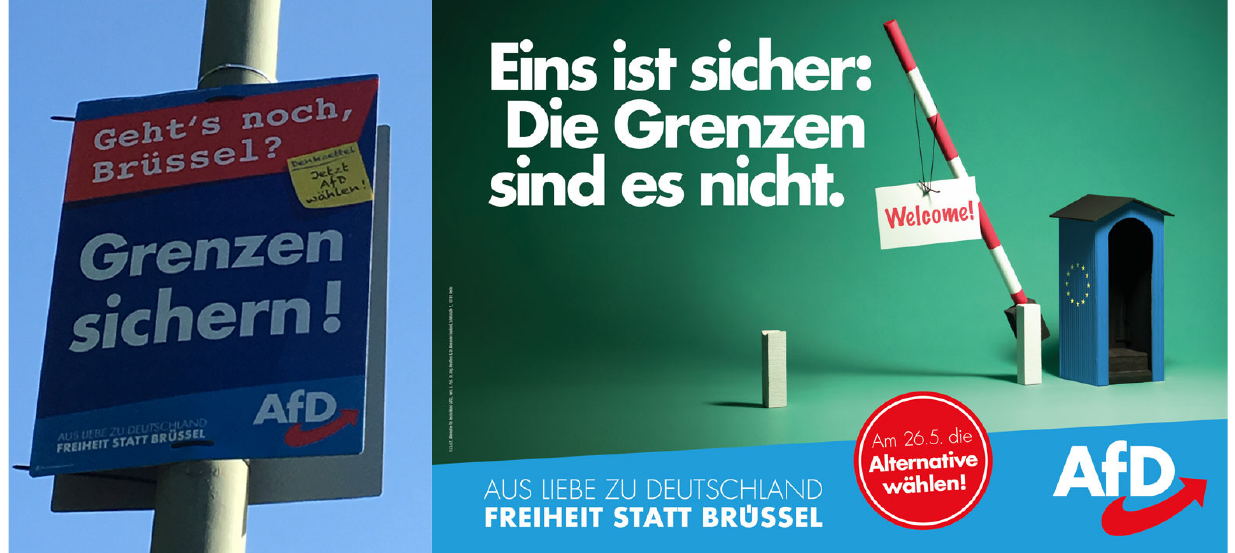
Figure 1. AfD European Parliament election posters, May 2019. Text on the left reads: “Can you manage Brussels? Secure the borders!” (photo by the author). Text on the right reads: “One thing is certain [ sicher , “safe”]: It’s not the border! Out of love for Germany. Freedom, not Brussels” (AfD,